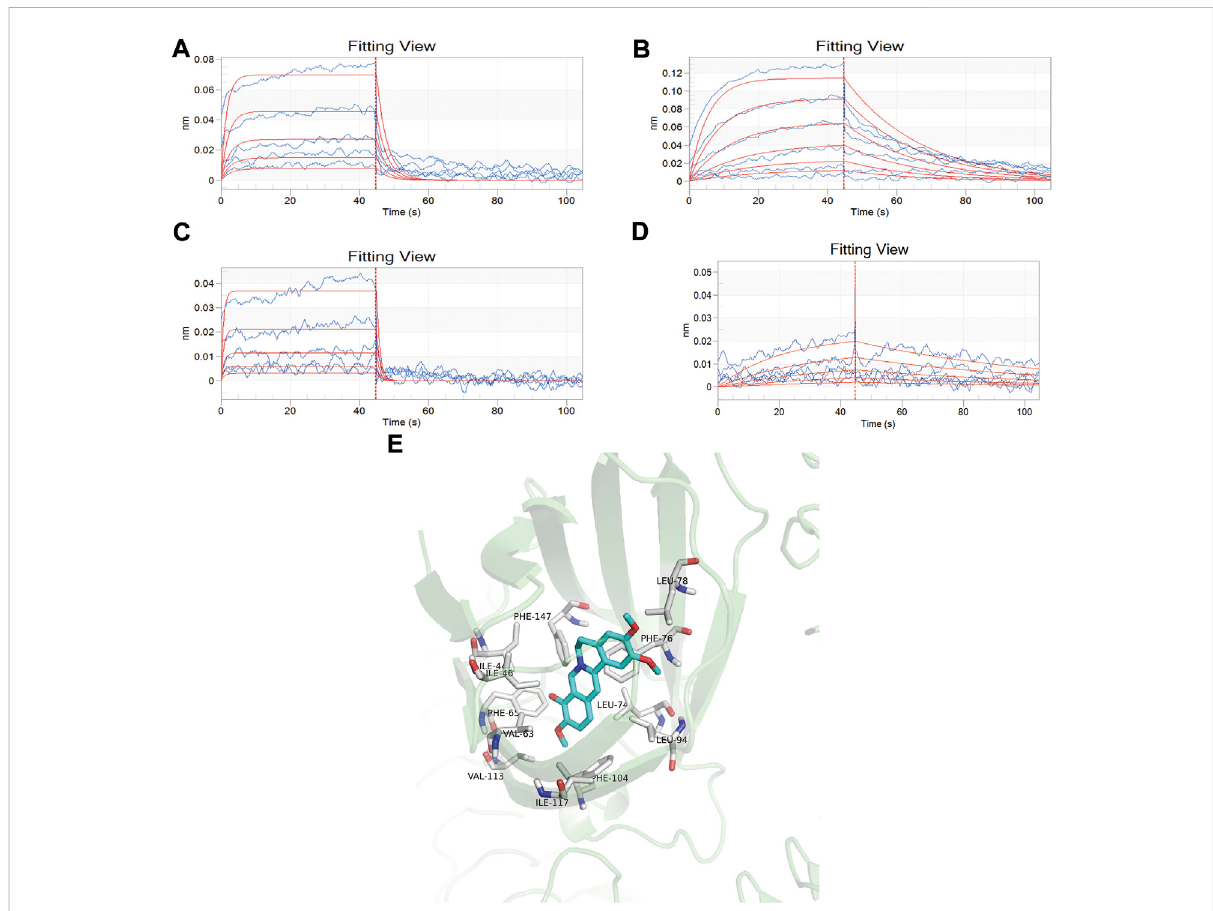
FIGURE 1 Screening of high-af fi nity active components by bio-layer interferometry assay and molecule docking. (A) Analysis of baicalin interaction with MD-2 by bio-layer interferometry assay, and the dissociation equilibrium constant in response to the concentration of baicalin varied from 0.0313, 0.0625, 0.125, 0.25, and 0.5 mM/ml; (B) Analysis of palmatine interaction with MD-2 by bio-layer interferometry assay, and the dissociation equilibriumconstantinresponsetotheconcentrationofpalmatinevariedfrom0.0156,0.0313,0.0625,0.125,0.25,and0.5 mM/ml; (C) Analysis of berberine interaction with MD-2 by bio-layer interferometry assay, and the dissociation equilibrium constant in response to the concentration of berberine varied from 0.0313, 0.0625, 0.125, 0.25, and 0.5 mM/ml; (D) Analysis of geniposide interaction with MD-2 by bio-layer interferometry assay, and the dissociation equilibrium constant in response to the concentration of berberine varied from 0.0625, 0.125, 0.25, 0.5, and 1.0 mM/ml. (E) Docking mode of MD2 protein and